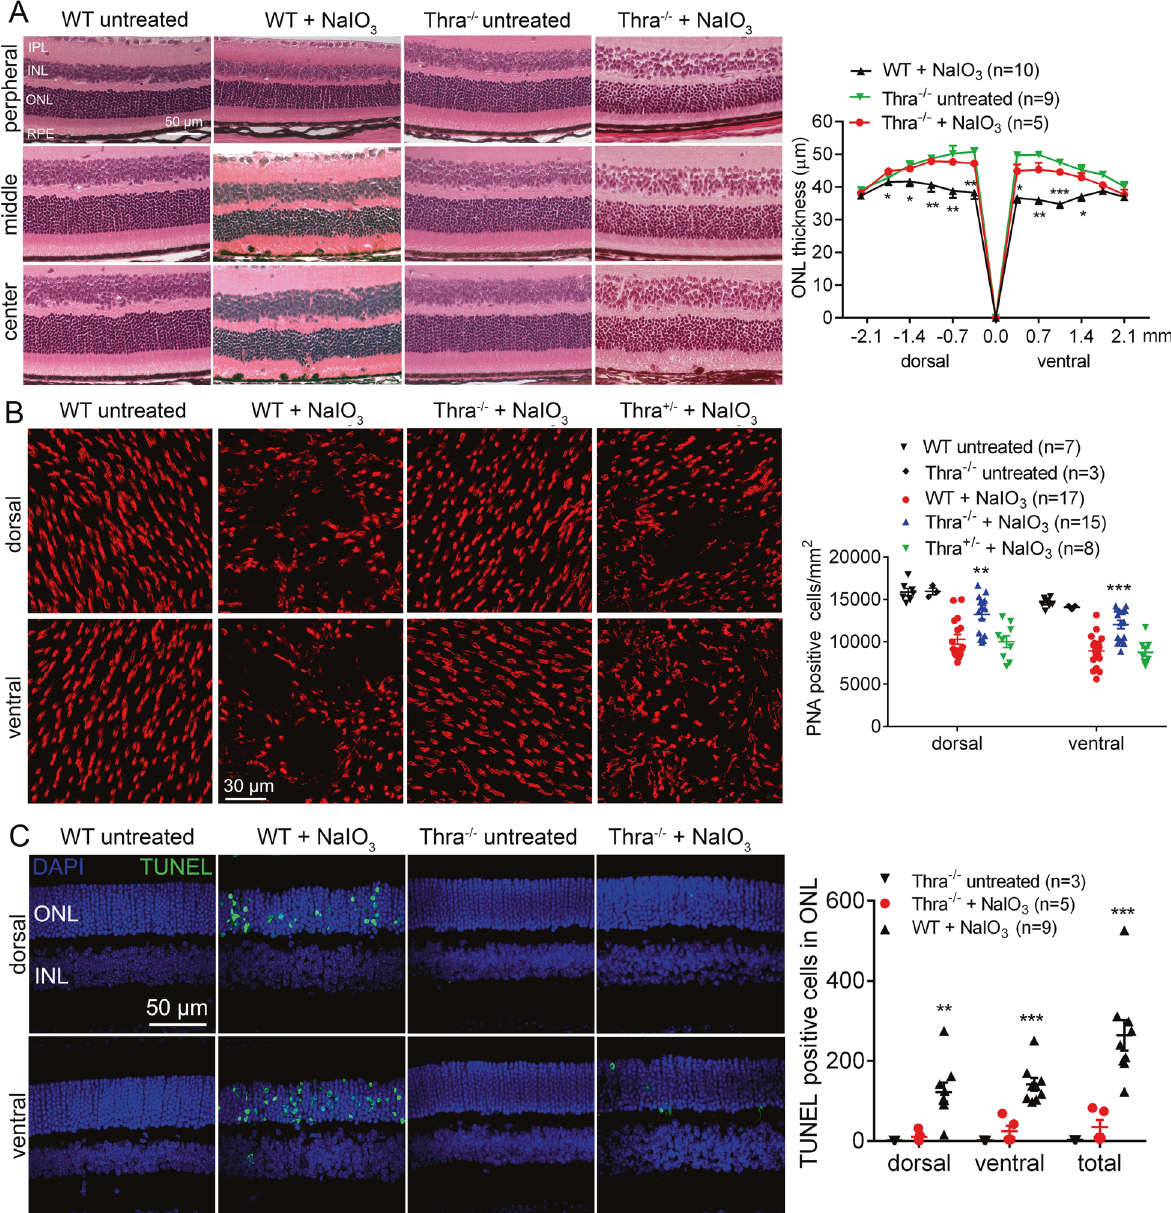
Fig. 2 Deletion of Thr α 1 protected rod and cone photoreceptors from cell loss induced by NaIO 3 . Retinal morphology, photoreceptor-layer integrity, and loss of photoreceptors were evaluated by light microscope and morphometric analysis in Thr α 1 − / − , Thr α 1 + / − , and wild-type mice at 3 days post NaIO 3 injection. Cone density was evaluated by PNA labeling on retinal whole mounts, and photoreceptor apoptosis was evaluated by TUNEL assay. A . Shown are representative light microscopic images of H&E-stained retinal sections, and corresponding quantitative analysis of ONL thickness in the dorsal and ventral regions. RPE retinal-pigment epithelial, ONL outer nuclear layer, INL inner nuclear layer, IPL inner plexiform layer. B Shown are representative confocal images of PNA labeling on retinal whole mounts, and corresponding quantitative analysis. C Shown are representative confocal images of TUNEL labeling on retinal sections and corresponding quantitative analysis. Data are represented as means ± SEM for 3 – 17 mice per group (* p < 0.05, ** p < 0.01, *** p < 0.001, compared with wild- type mice treated with NaIO 3